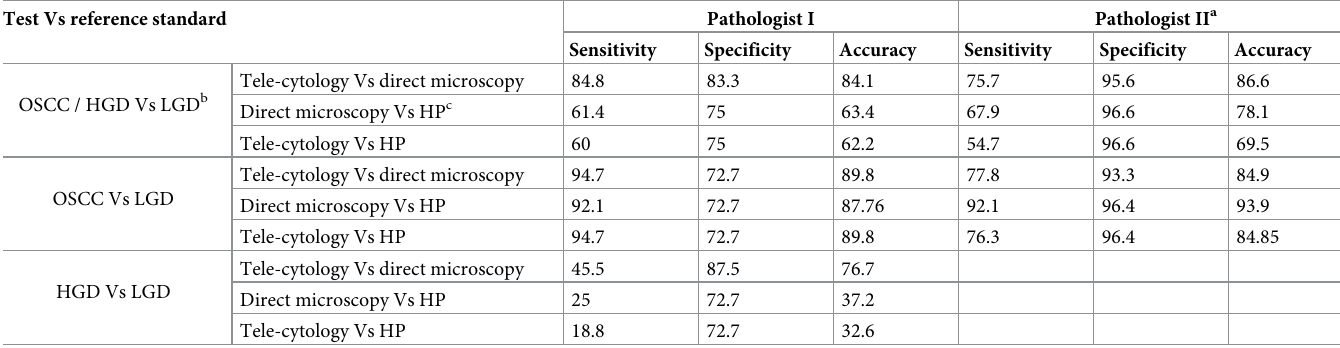
Table 1. Sensitivity, specificity and accuracy of Tele-cytology and direct